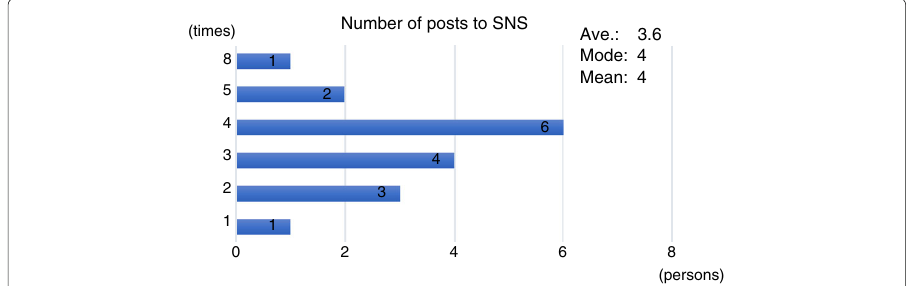
Fig. 9 The number of post to